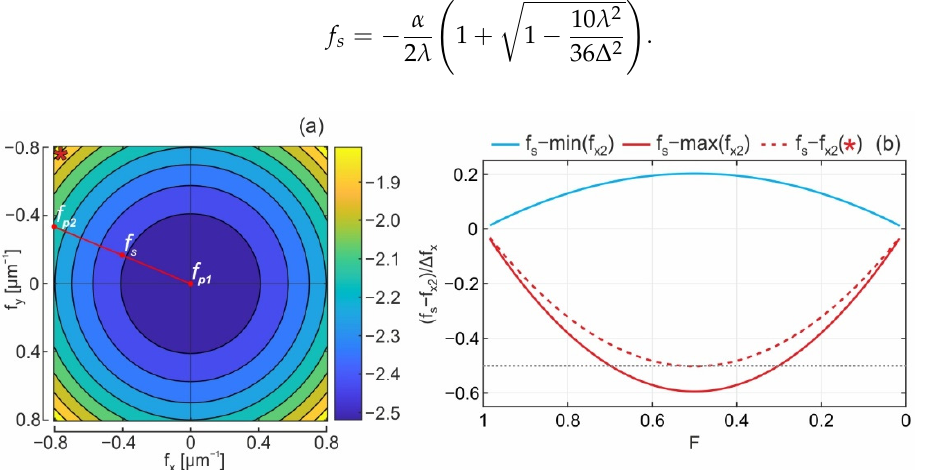
Figure 3. ( a ) Difference map of spatial frequencies; ( b ) The error of introduced frequency shift as a function of overlap